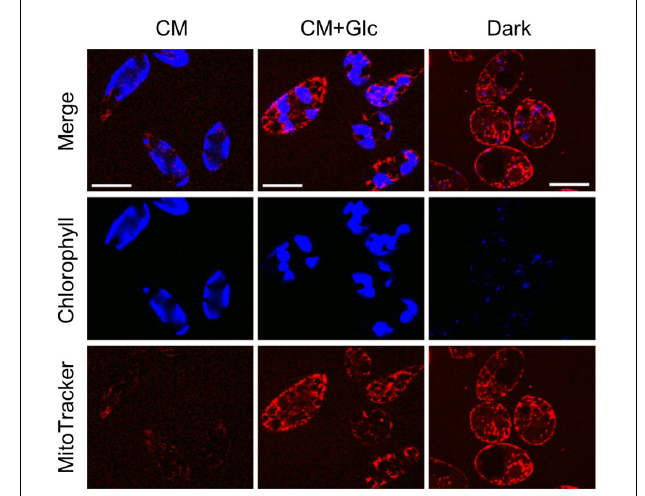
FIGURE 4 | Confocal laser scan microscopy of the cells grown under photoautotrophic, photomixotrophic, and heterotrophic conditions. Typical images of the cells grown in each culture were shown. Bar = 20 µ